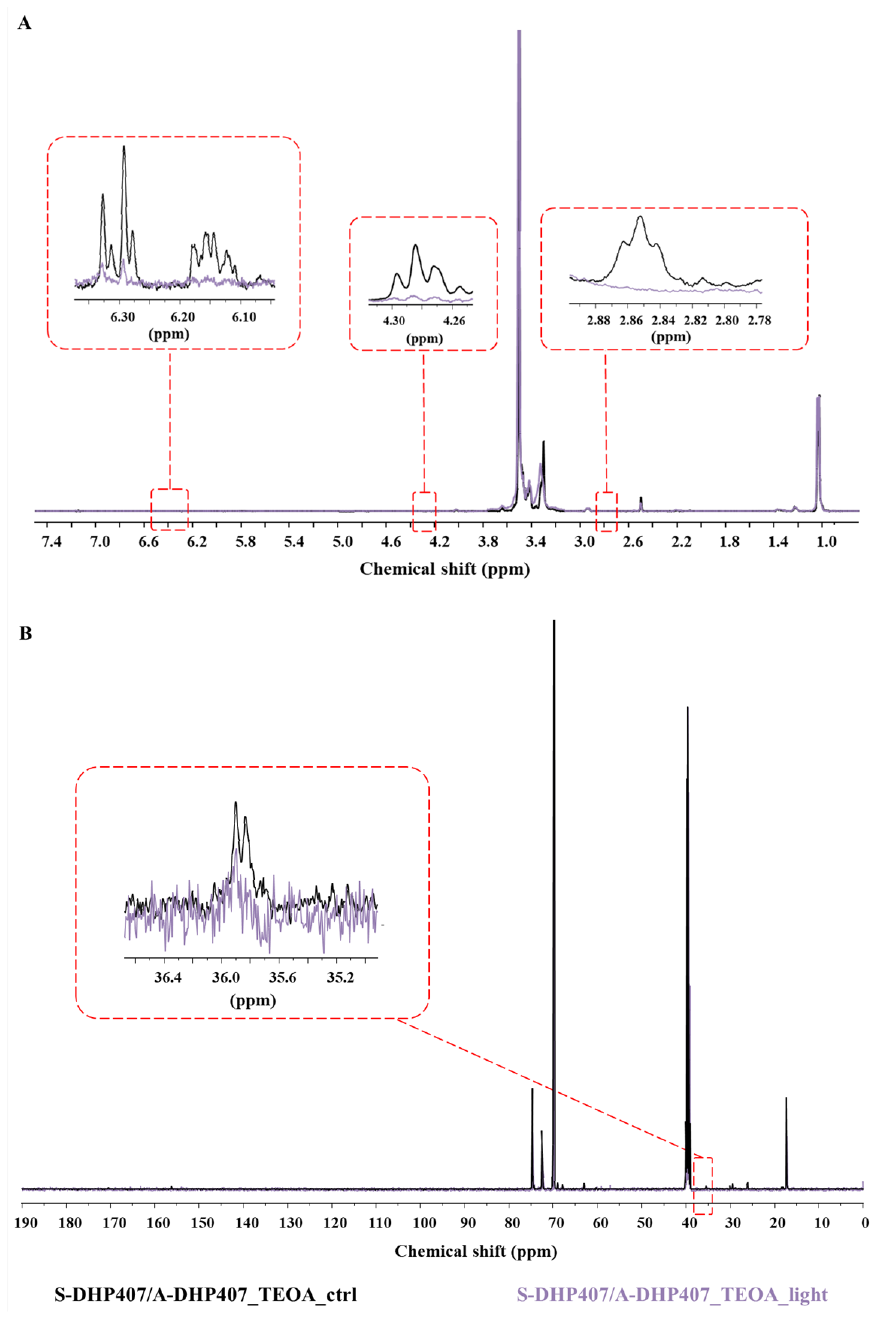
Figure 10. 1 H NMR spectra of S-DHP407/A-DHP407_TEOA_light (violet) and S-DHP407/A- DHP407_TEOA_ctrl (black) samples ( A ). Magnified inserts highlight differences in the bands at 2.8 ppm and 4.3 ppm corresponding to the resonances of protons in -CH 2 groups of acrylate-bearing chains, and the set of signals at 6.1–6.3 ppm ascribed to protons involved in the double bonds. 13 C NMR spectra of S-DHP407/A-DHP407_TEOA_light (violet) and S-DHP407/A-DHP407_TEOA_ctrl (black) samples ( B ). Magnified insert evidences changes in the signals at 35.8 ppm and 35.9 ppm, due to the methylene carbons of TGA molecules showing free –SH moiety or converted into S-S bonds, respectively.